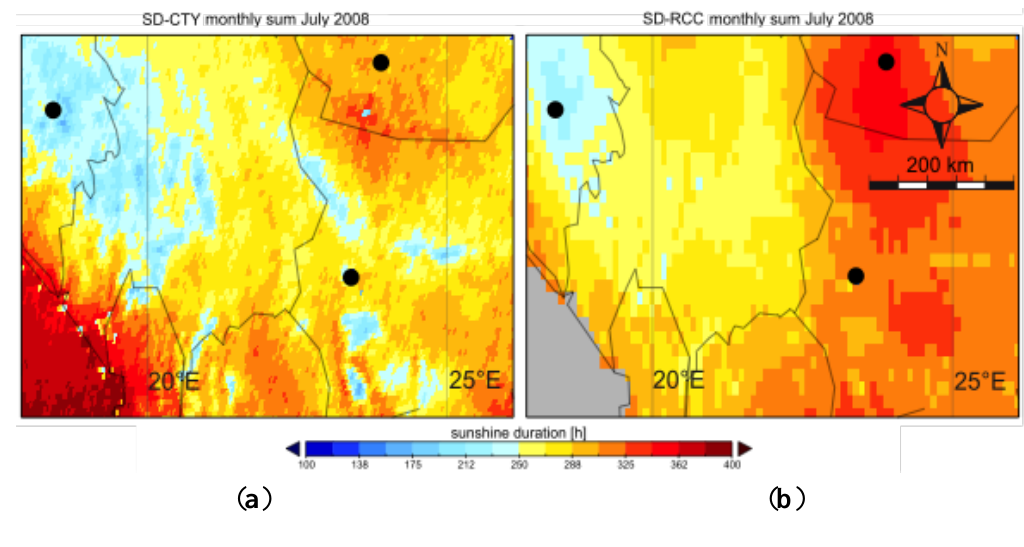
Figure 8. SD-CTY ( a ) and for SD-RCC ( b ) for July 2008. The figures show a sector of about 3° longitude × 8° latitude centered over the